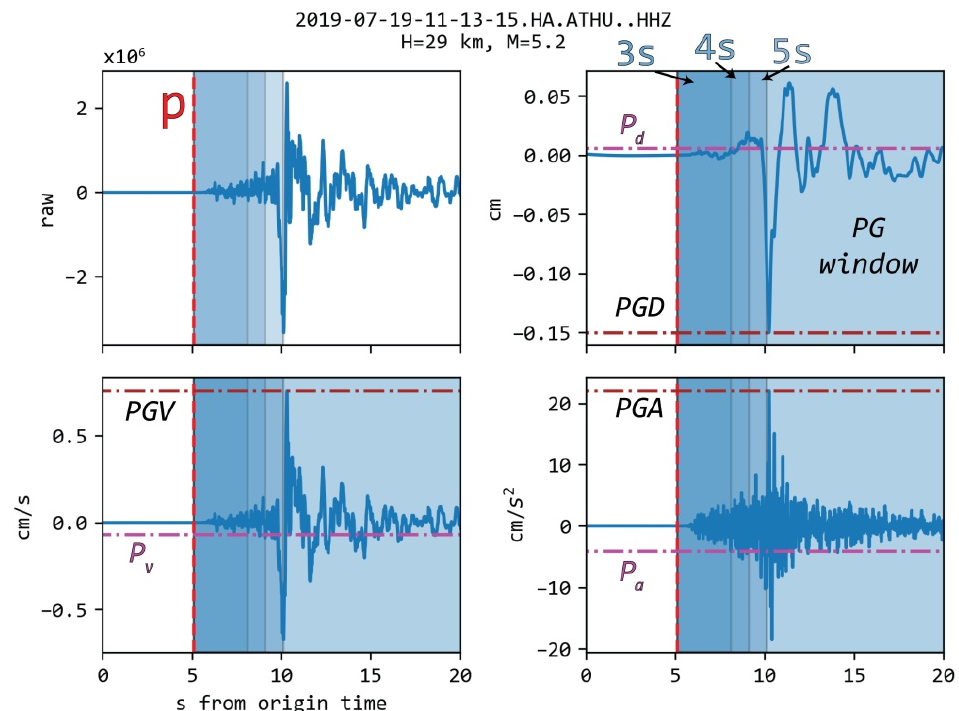
Figure 2. Vertical recording of the M w = 5.2 July 2019 event at station ATHU (located in Athens, approximately 29 km from the epicenter). The raw ( upper left ), displacement ( upper right ), velocity ( bottom left ), and acceleration ( bottom right ) recordings are shown. The horizontal magenta line indicates the P d, υ ,a measurement for a signal window of 3 s length, while the horizontal brown line showcases the determined peak ground motion (e.g., PGA for acceleration). The automatic pick is denoted by the vertical red dashed line and the S arrival by the vertical blue dashed line. The following signal windows are highlighted by the gradually less shaded areas (from darkest to brightest): 3 s, 4 s, 5 s, and peak ground measurements window. The hypocentral distance (H) and magnitude (M) are also noted.